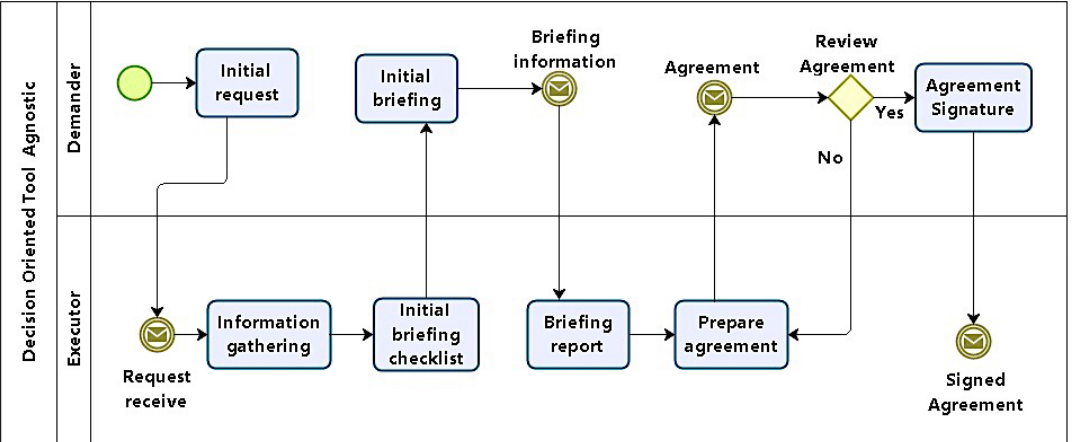
Figure 2. Phase 1: Task